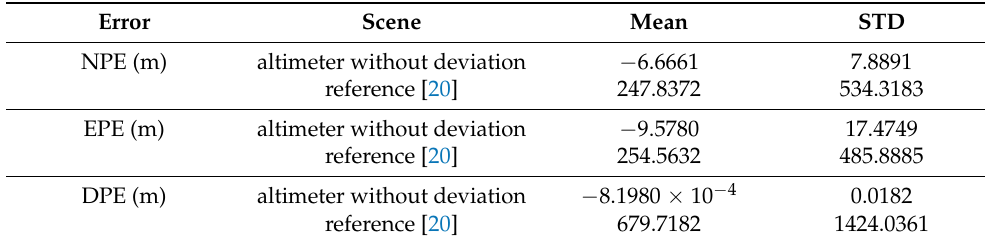
Table 11. Statistics of position error.